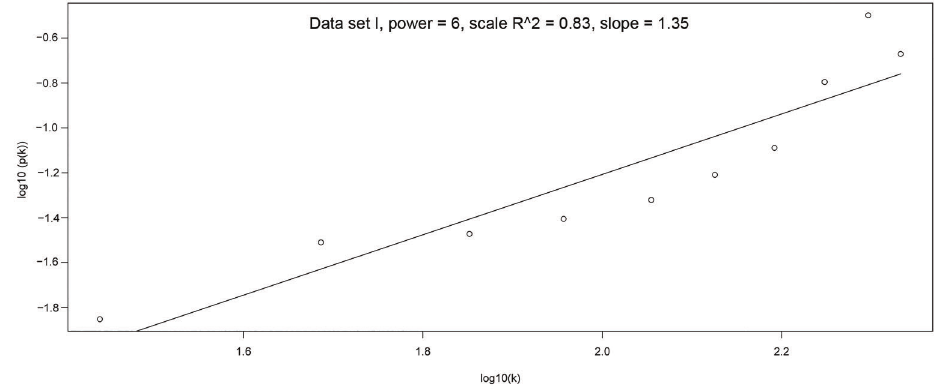
Figure 3. Gene degrees in co-expression network and distribution of corresponding numbers. Horizontal axis indicates values of gene degrees (k); vertical axis indicates proportion of gene with k degree, that is, p (k).